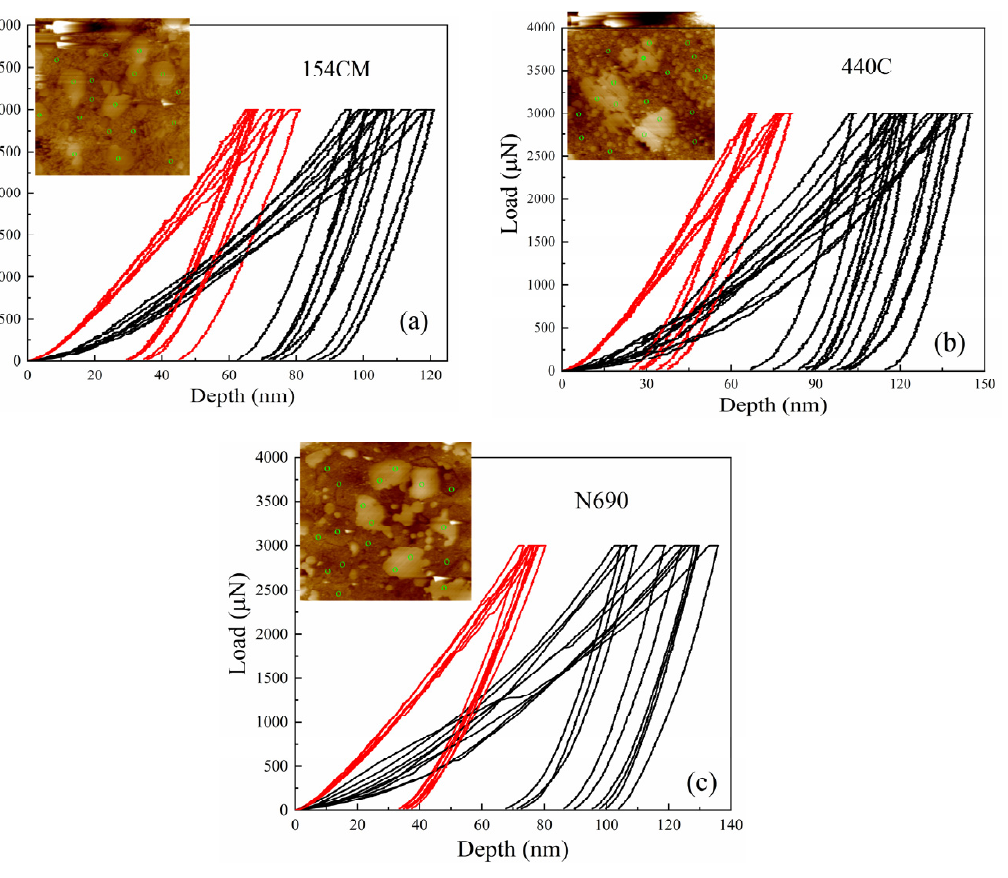
Figure 10. Load-displacement curves for nanoindentation tests on matrix and carbide M23C6 phases in stainless steels: ( a ) 154CM, ( b ) 440C, and ( c ) N690.